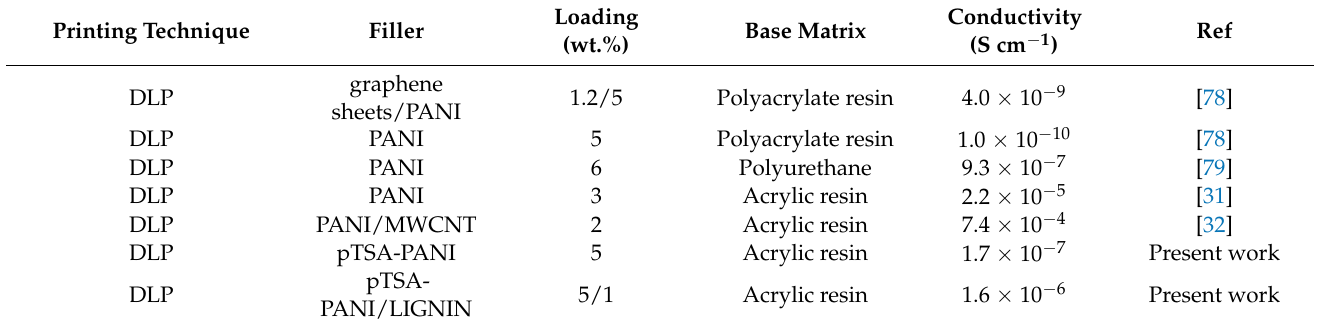
Table 5. Recent research on light-curable 3D printed resins with electrical properties based on PANI. Printing